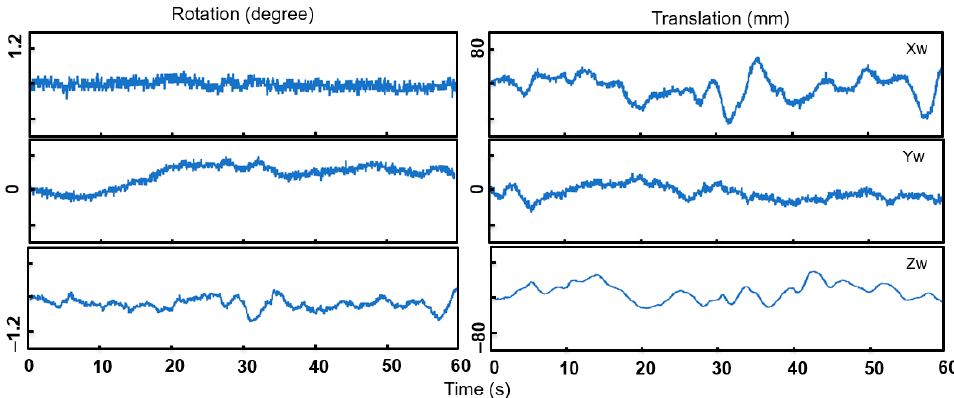
Figure 18. Six degrees of freedom motion of the UAV ( Z w = − 1000).